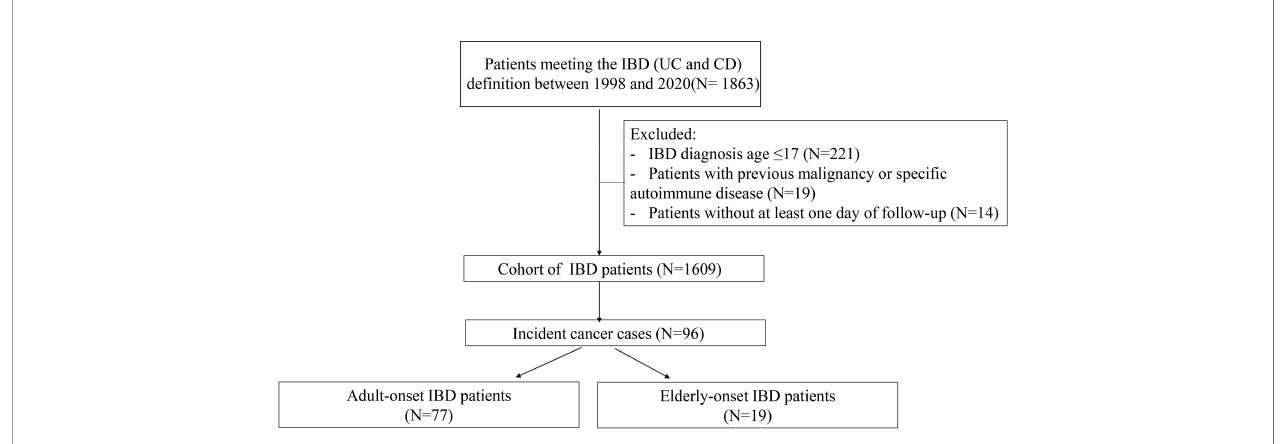
FIGURE 1 | Cohort de fi nition and fl owchart.